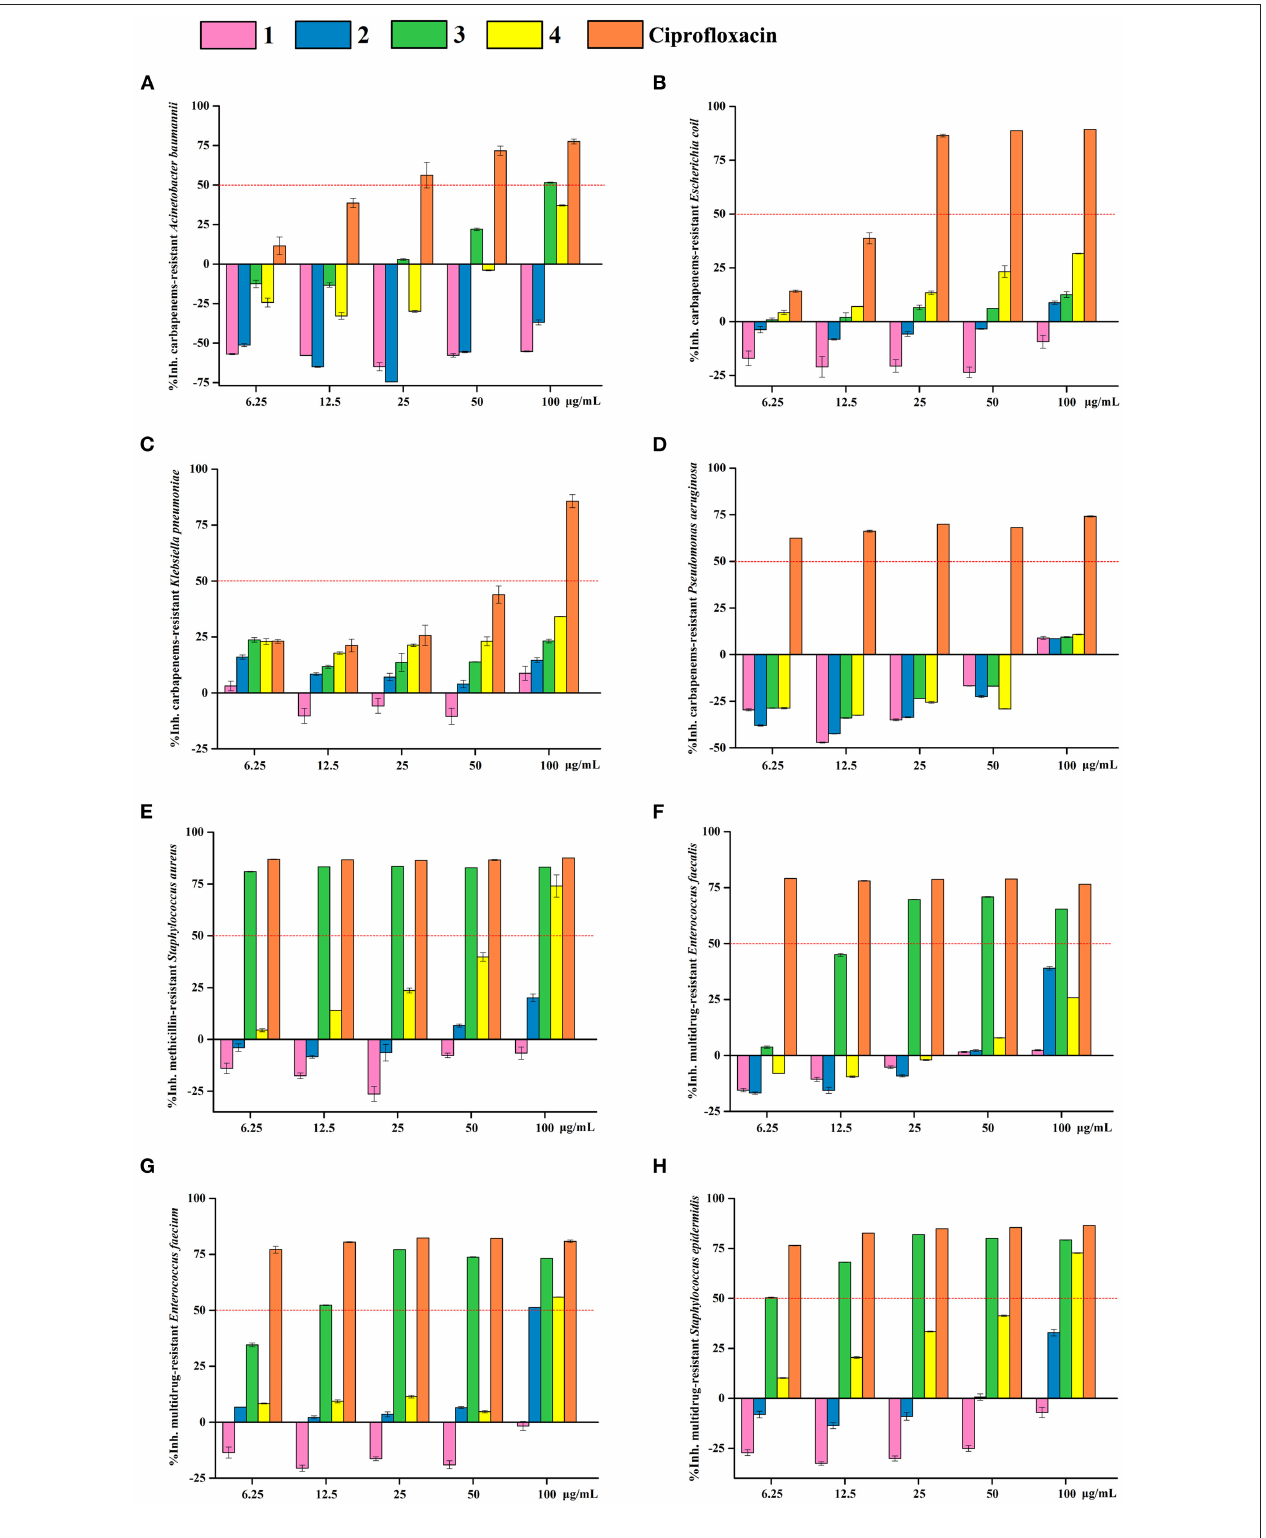
FIGURE 5 | Antibacterial activity of OA derivatives 1 – 4 . The inhibitory rates of OA derivatives 1 – 4 against carbapenems-resistant A. baumannii (A) , carbapenems-resistant E. coli (B) , carbapenems-resistant K. pneumoniae (C) , carbapenems-resistant P. aeruginosa (D) , methicillin-resistant S. aureus (E) , multidrug-resistant E. faecalis (F) , multidrug-resistant E. faecium (G) , and multidrug-resistant S. epidermidis (H) . Pink columns indicate OA 1 , blue columns indicate LA 2 , green columns indicate 3-MOA 3, and yellow columns indicate methyl 3-methylorsellinate 4 . Ciprofloxacin was used as the positive control.